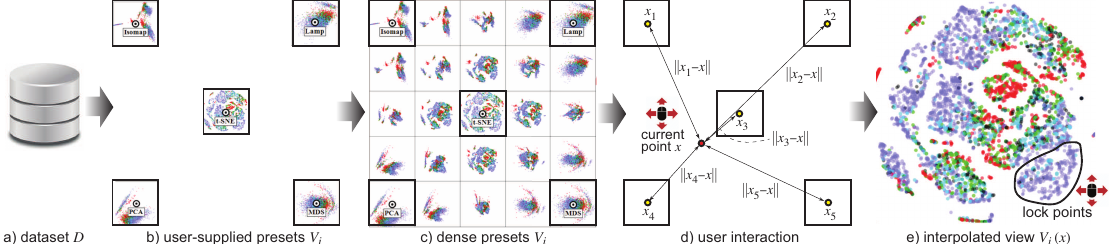
Figure 2. Proposed animation-based exploration pipeline. See Section